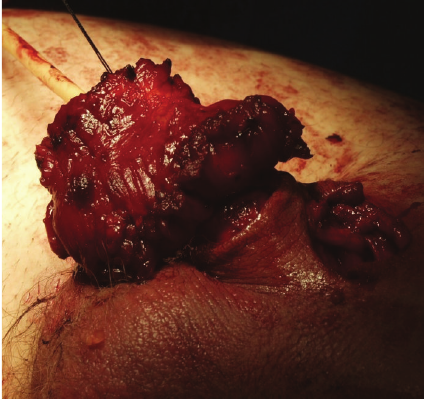
Figure 6: The flap being sutured to the distal penile neurovascular bundle.